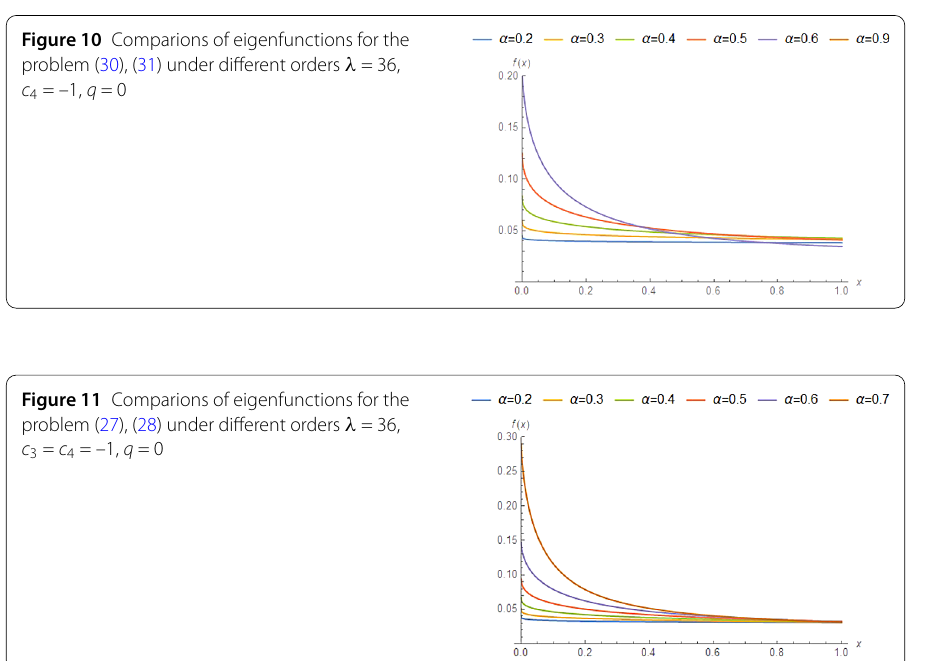
lems (24)–(25), (30)–(31), and (27)–(28) with each other in Fig. 12. We compare the eigen- functions of problem (24)–(25) with different orders, different eigenvalues, different do- mains, and different potential functions in Fig. 13, Fig. 14, Fig. 15, and Fig.